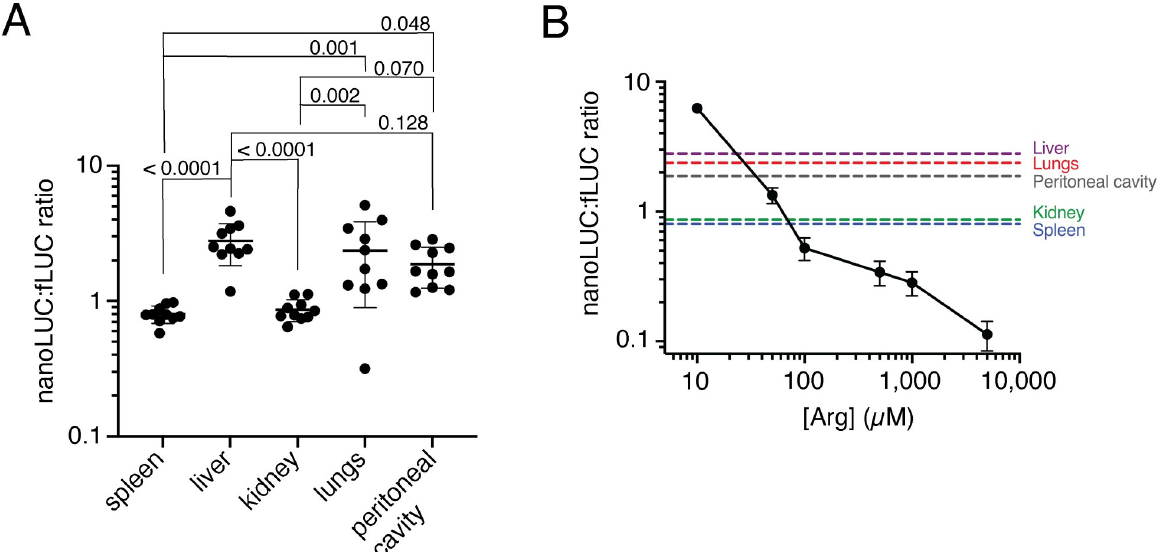
Fig 5. T . gondii parasites modulate Tg ApiAT1 expression in vivo . ( A ) NanoLUC:fLUC ratios in apiAT1 5’ -nanoLUC: tub 5’- fLUC dual reporter parasites harvested from a range of organs from infected mice. Mice were infected intraperitoneally with 10 3 parasites, and euthanised seven days post-infection. Data were derived from two independent experiments with 5 mice each. P values were calculated using a one-way ANOVA with Tukey’s multiple comparisons test. P values not shown were > 0.60. ( B ) The mean nanoLUC:fLUC luminescence ratios of apiAT1 5’ -nanoLUC: tub 5’- fLUC parasites harvested from various mouse organs and peritoneal cavity in ( A ) shown as dashed lines from the y axis, mapped onto the nanoLUC:fLUC luminescence ratios of apiAT1 5’ -nanoLUC: tub 5’- fLUC parasites grown in vitro at a range of [Arg] (solid black line; these data are redrawn from the data depicted in Fig 2B). In vitro data represent the mean ± s.e.m. from nine independent experiments.